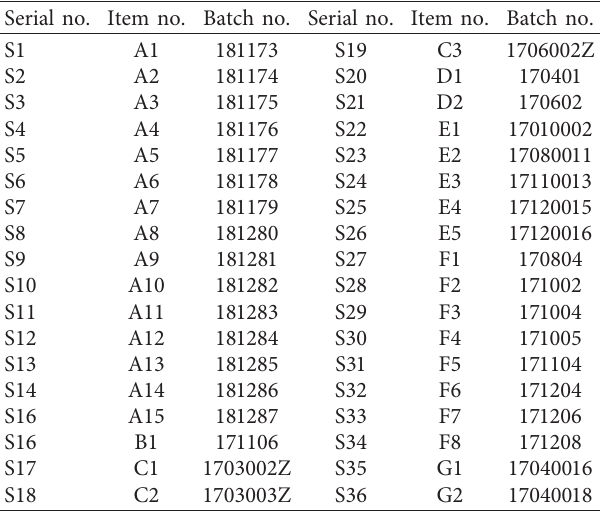
Table 1: Source and serial number of each passel sample. Serial no. Item no. Batch no. Serial no. Item no. Batch